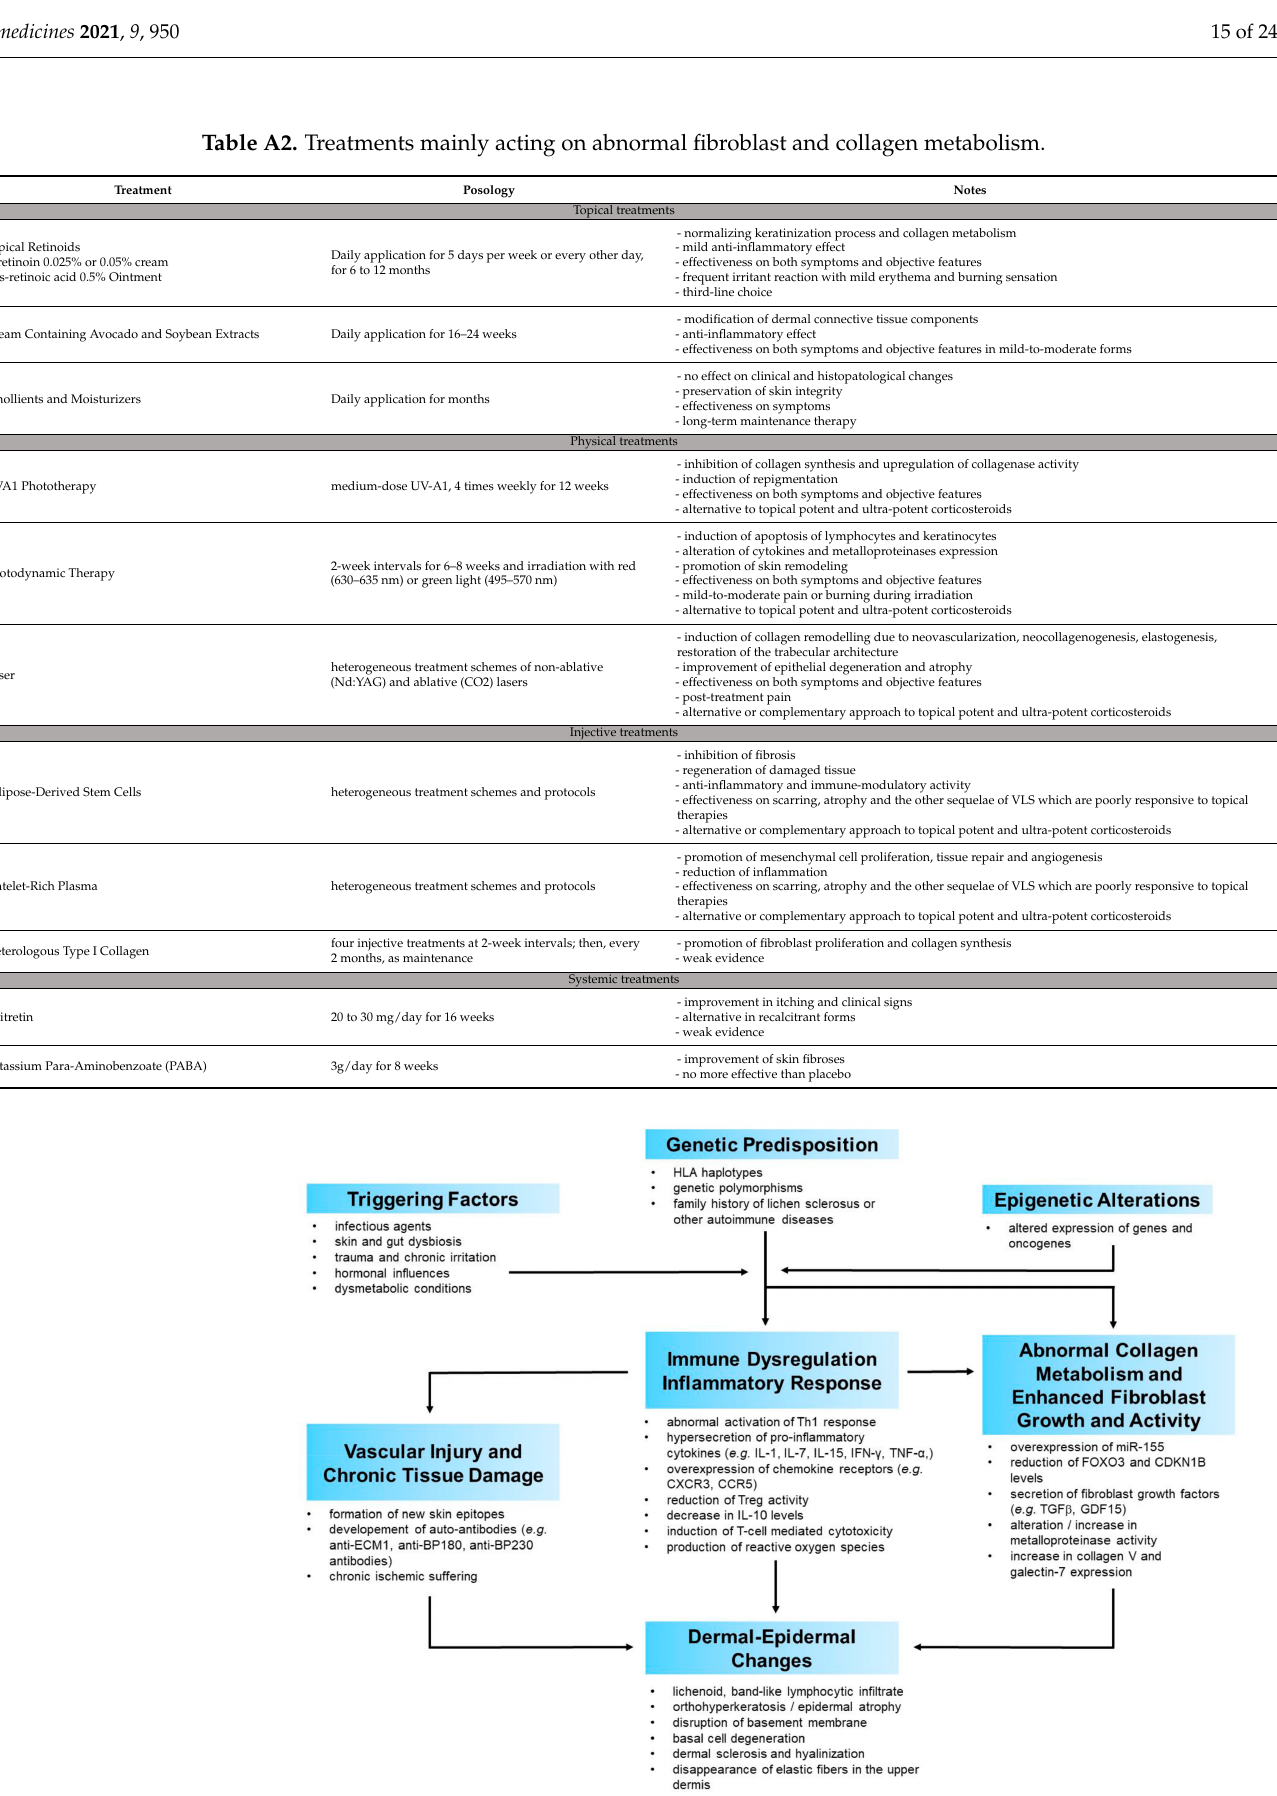
Figure A1. Proposed pathogenetic model of vulvar lichen